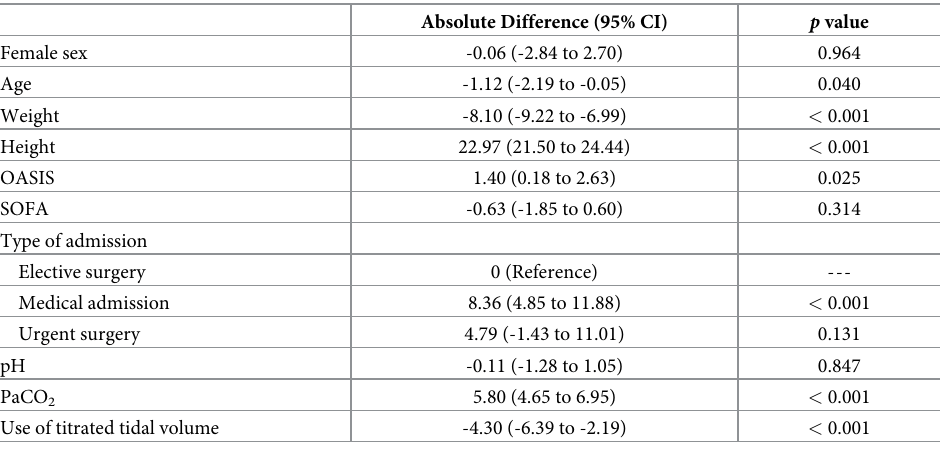
Table 2. Effect on low tidal volume ventilation � .